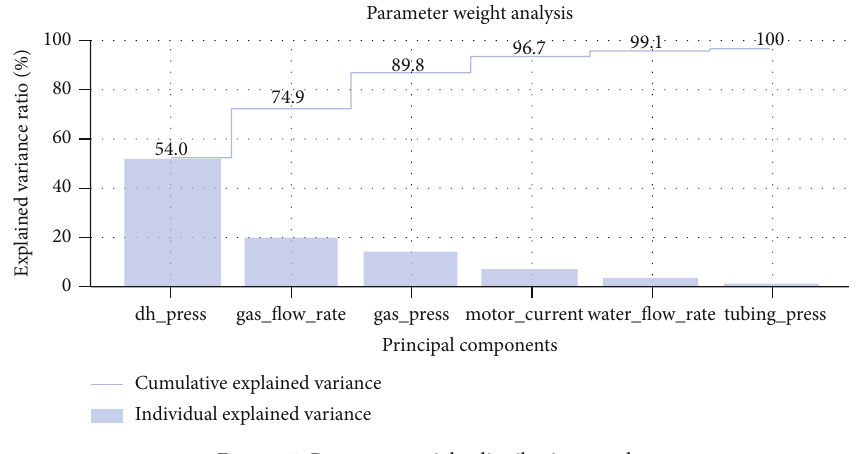
Figure 4: Parameter weight distribution